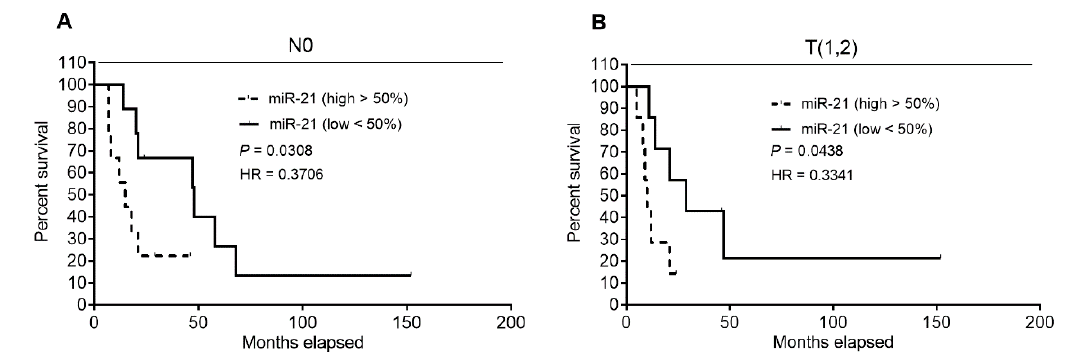
Figure 6. Analysis of patients’ DSS association with miR-21 levels in subgroups with N0 and T(1,2) tumors using Kaplan–Meier curves. Patients in the N0 ( A ) and T(1,2) ( B ) subgroups were divided according to the median (low < 50%, high > 50%) of expression of miR-21. Low expression of miR-21 was significantly associated with improved DSS in both tested cohorts. Statistical significance was evaluated by applying log-rank test analysis, reaching p = 0.0308 for N0 patients and p = 0.0438 for patients with T(1,2) tumors.